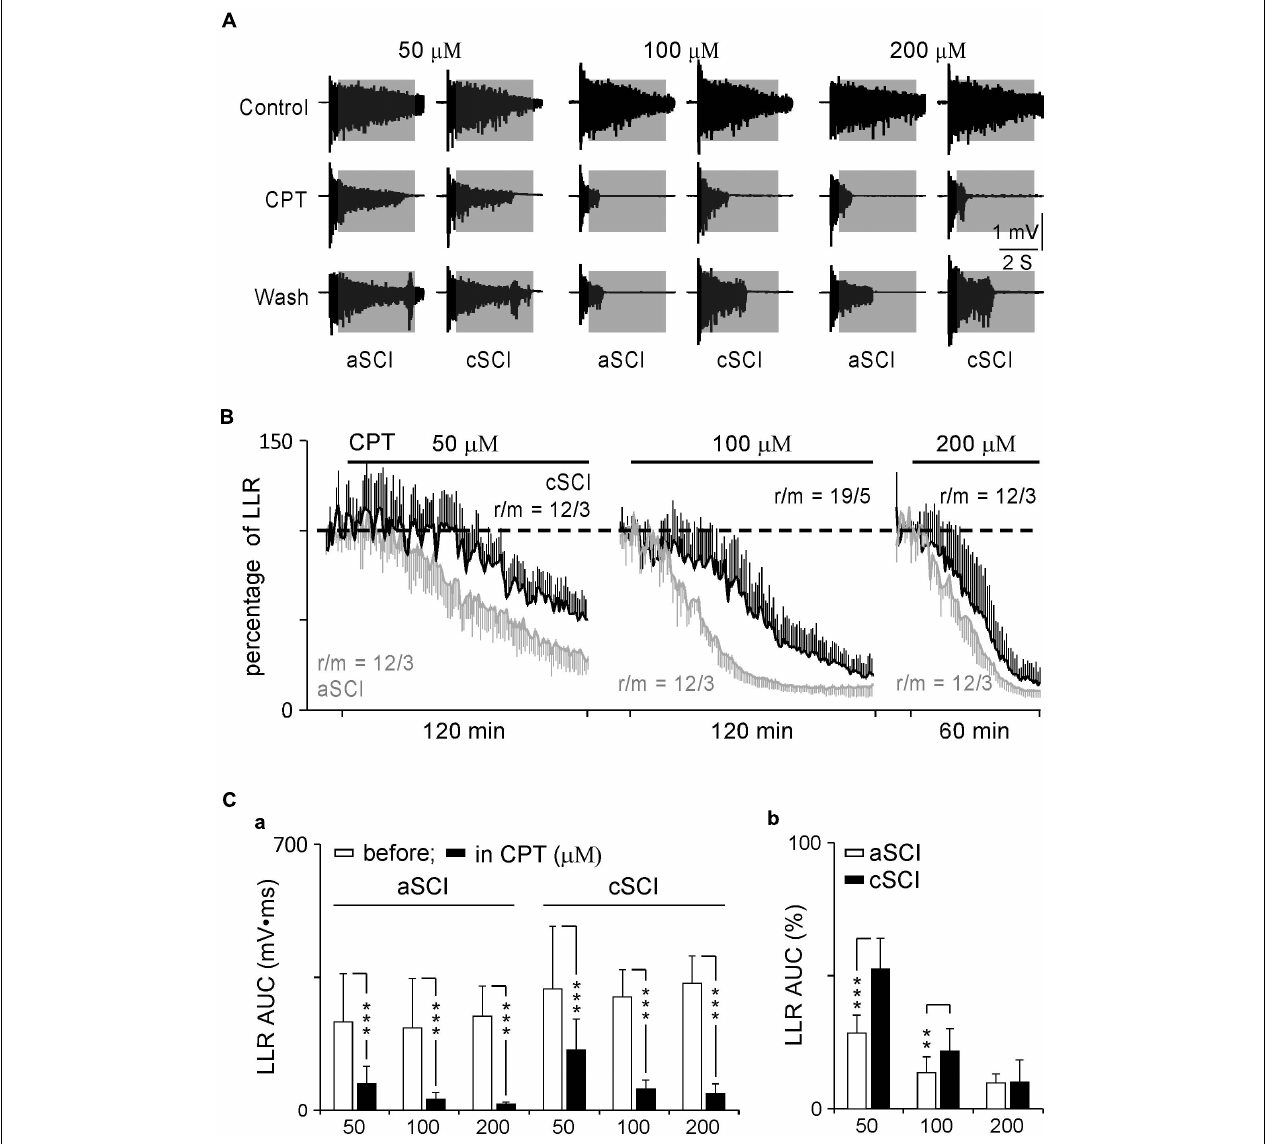
FIGURE 2 | Effects of CPT on LLRs. (A) Sample recordings display the inhibitory effects of CPT on LLRs at different concentrations. Shadow areas mark LLRs. (B) Time courses of inhibitory effects of CPT on LLRs. The AUC values of LLRs are converted to percentage changes using the controls before the drug’s application. r/m, roots/mice. (C) Histograms display the inhibitory effects of CPT on LLRs. The histograms in a shows AUC values before and after CPT applications at three concentrations for both types of mice. The statistical significance is determined by paired t -test and indicated by asterisks (*** p < 0.001). The histograms in b compare the percentage changes of LLRs between aSCI and cCSI mice. The significant differences are analyzed by unbalanced two way ANOVA (mouse type: p = 6.11 × 10 − 10 , CPT concentration: p = 2.03 × 10 − 23 ) and post hoc t -test (** p < 0.01, *** p <